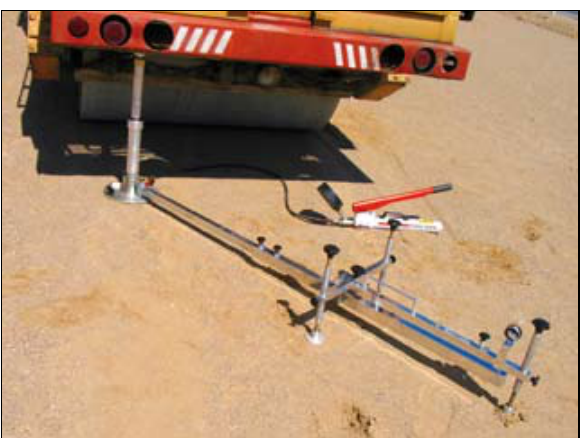
fig. 1. Static beam “Strassentest”